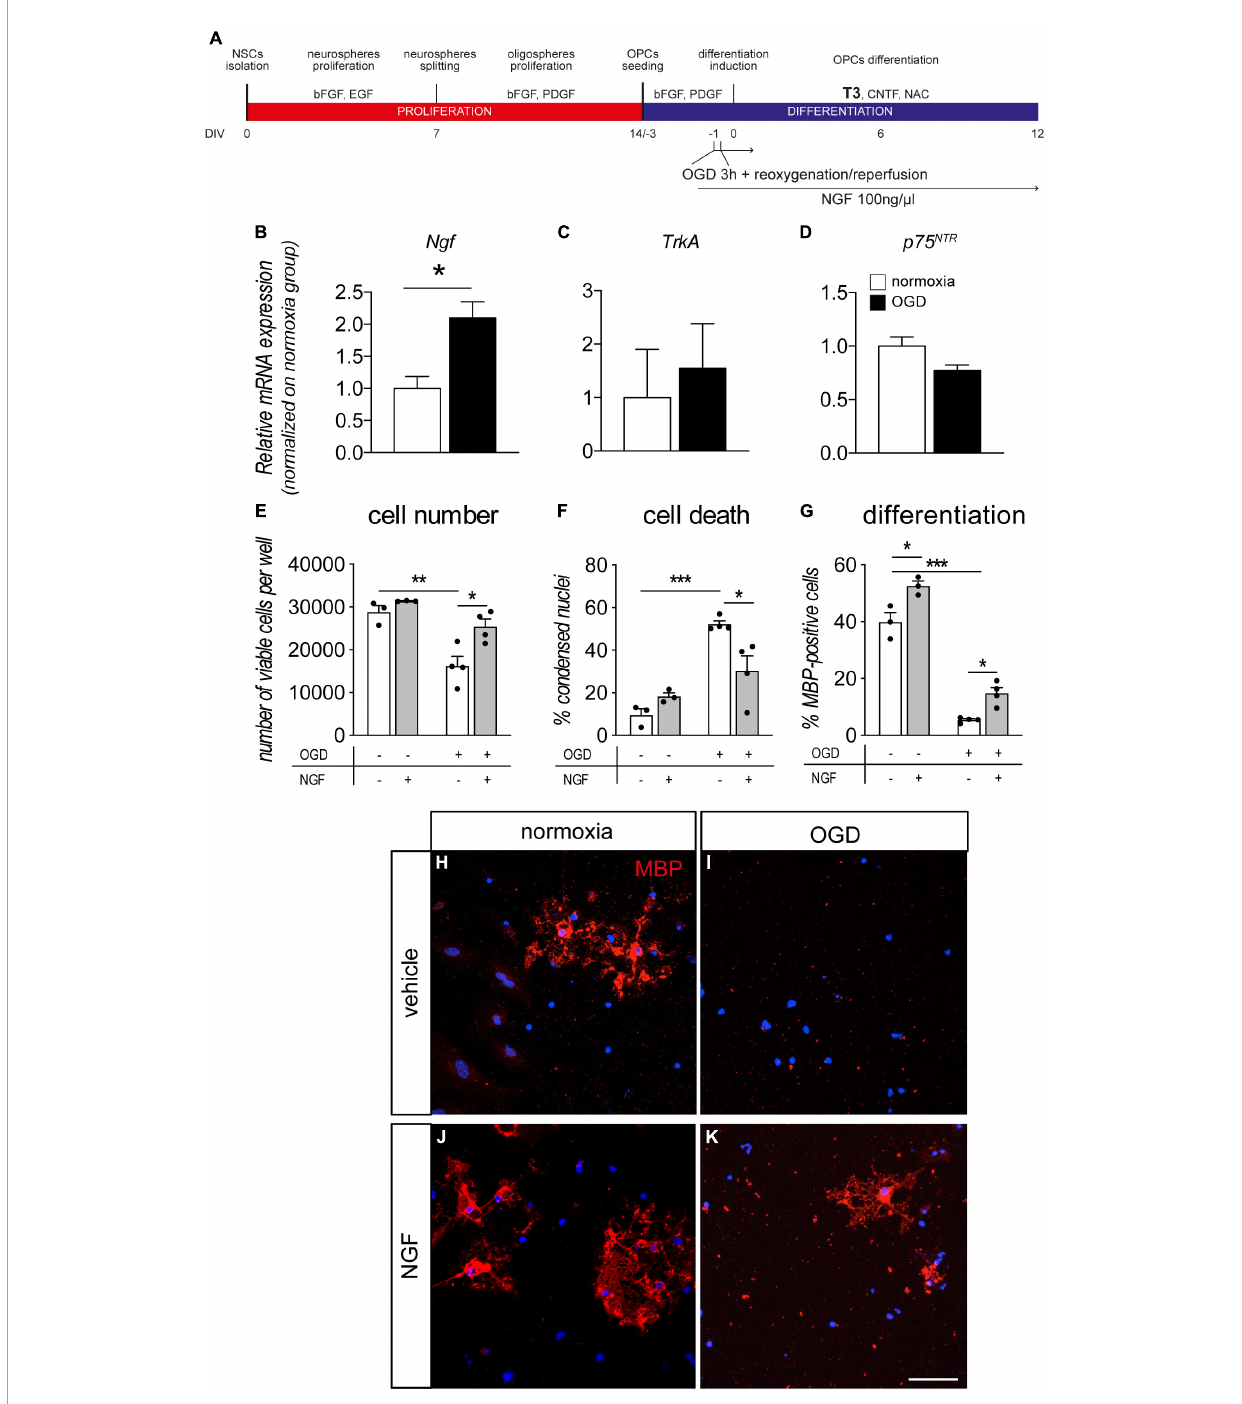
FIGURE4 NGF boosts OPC differentiation and protects from OGD. (A) NSC-derived mixed OPC/astrocyte cultures were exposed to OGD 24 h prior to T3-mediated differentiation induction (–1 DIV). Cells were treated with vehicle or NGF (100 ng/ml) beginning 1 h prior to OGD. Cultures were analyzed for gene expression 24 h after OGD exposure (0 DIV) and for cell number/cell death and differentiation at the end of the differentiation phase (12 DIV). (B–D) Graphs show relative mRNA expression of NGF (B) , TrkA (C) and p75 NTR (D) genes, following 3 h of OGD and 24 h of reoxygenation/reperfusion, in culture exposed and unexposed to OGD and normalized on normoxia-exposed groups; n = 3 for all the presented groups. (E–G) Graphs show cell number (E) , percentage of condensed nuclei (cell death, panel F ) and percentage of MBP-positive cells (cell differentiation, panel G ), in cultures exposed to normoxia ( n = 3) or OGD ( n = 4) and treated or untreated with NGF (100 ng/ml) (normoxia, n = 3; OGD, n = 4), at the end of the differentiation phase (12 DIV). (H–K) Representative images of MBP-positive cells (myelinating OLs) in cultures exposed to normoxia (H,J) or OGD (I,K) and treated with vehicle (H,I) or NGF (J,K) . Scale bar: 20 µ m. Bars represent mean ± SEM and single dots in the graphs represent single independent experiments analyzed by high content screening (E–G) . Statistical analysis: Student’s t -test (B–D) or two-way ANOVA followed by Sidak’s post-test (E–G) . Asterisks represent the differences between indicated groups (* p < 0.05; ** p < 0.01; *** p < 0.001). bFGF, basic fibroblast growth factor; DIV, day in vitro ; EGF, epidermal growth factor; MBP, myelin basic protein; NGF, nerve growth factor; OGD, oxygen-glucose deprivation; OLs, oligodendrocytes; p75 NTR , low affinity nerve growth factor receptor; PDGF, platelet derived growth factor; T3,